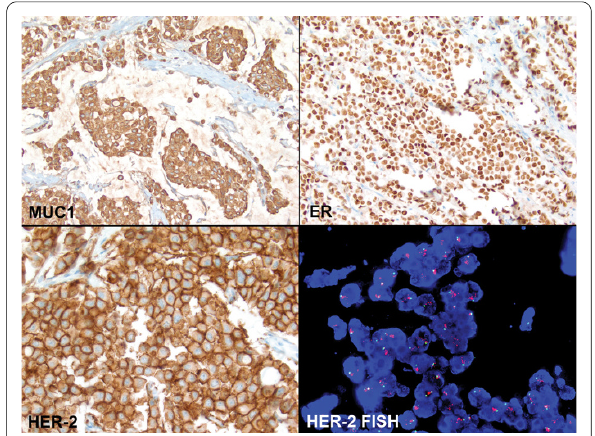
Figure 2 Characteristics of the invasive lobular carcinoma with extracellular mucin . The tumor cells revealed strong cytoplasmic MUC1 staining (top left, immunohistochemistry, ×200), but were neg- ative for MUC2, MUC4, MUC5AC and MUC6 (images not shown). The tumor cells were positive for ER (top right, ×400), negative for PR (im- age not shown), and positive for HER-2/neu with 3+ staining (bottom left, ×400). FISH study confirmed the amplification of HER-2 gene (bot- tom right, ×1,000).